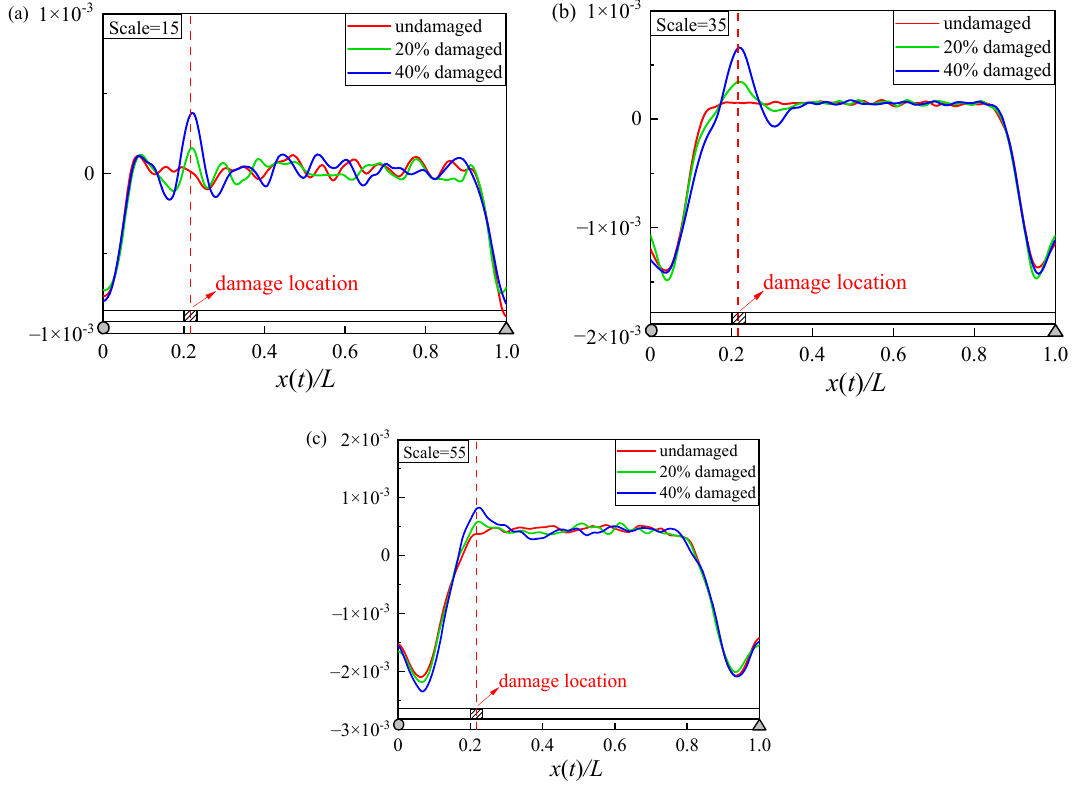
Figure 11. CWC under different scale factors: ( a ) scale = 15; ( b ) scale = 35; ( c ) scale = 55.